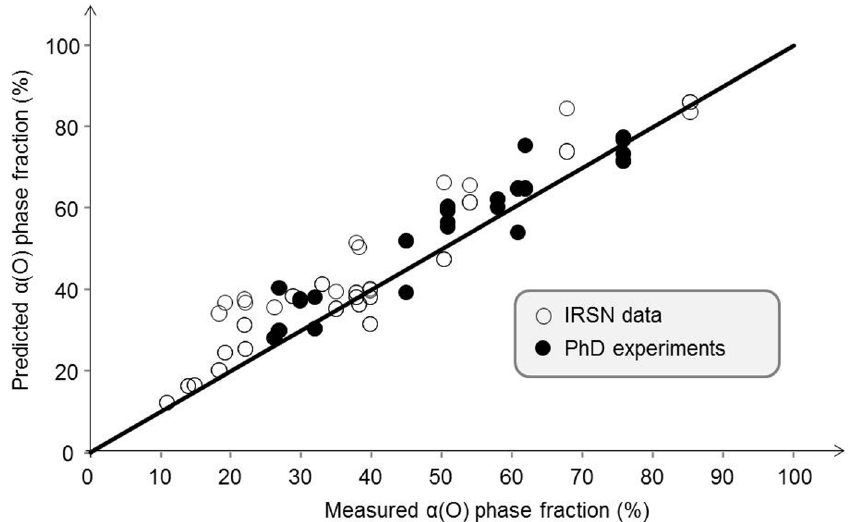
Fig. 8. Comparison between predicted and measured a (O) phase